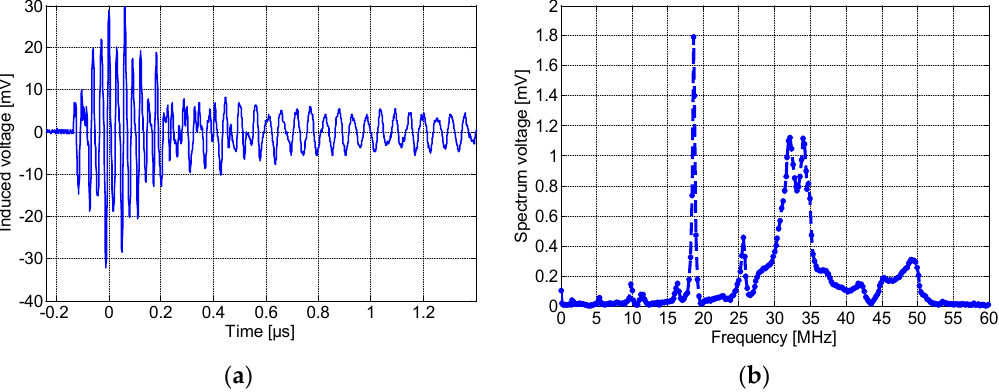
Figure 14. ( a ) The time-domain wave of the output voltage at 8.2 kV and ( b ) its frequency spectrum detected by the spiral sensor placed at P3.